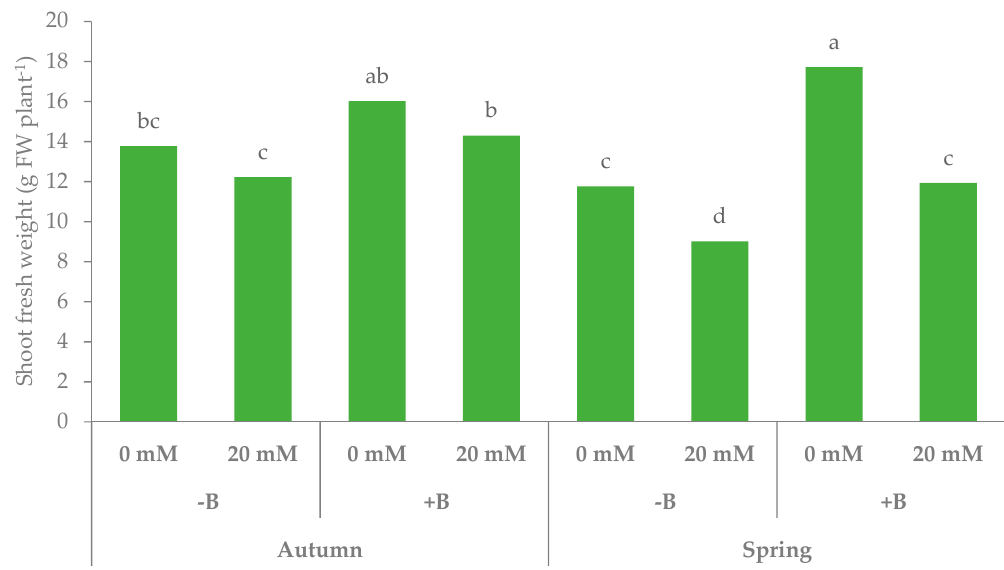
Figure 5. Shoot fresh weight of leaf lettuce plants grown during autumn and spring in nutrient solutions containing different levels of NaCl (0 mM and 20 mM) and with (+B) or without (-B) bacterial biostimulant (bars with different letters are significantly different at p < 0.05, according to the LSD test).